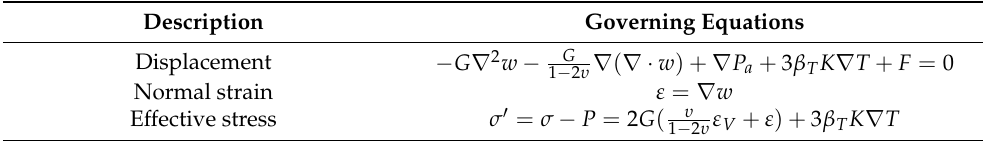
Table 2. Three-dimensional extended Biot mechanical